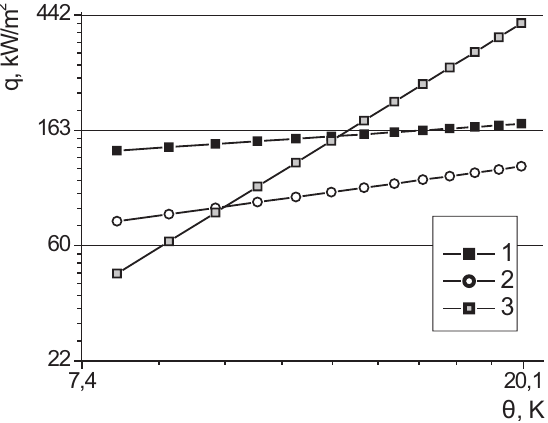
Figure 7. Superheat gradient vs. superheat for all the porous Figure 9. Boiling curves for ethyl alcohol (8K < q < 17K); coatings and the smooth surface (8K < q < 20K); ethyl alcohol 1 – metal-fibrous microstructure of 81% porosity, 2 – metal- boiling: 1 – metal-fibrous microstructure of 81% porosity, fibrous microstructure of 67% porosity, 3 – smooth 2 – metal-fibrous microstructure of 67% porosity, 3 – smooth surface